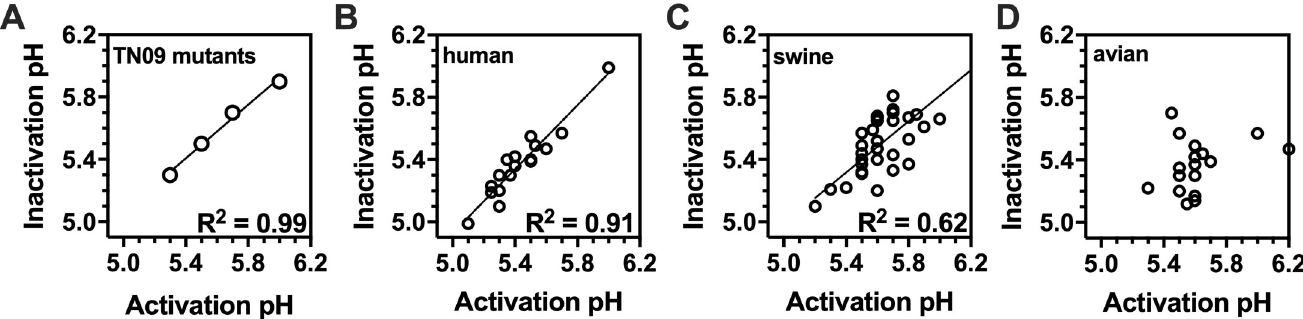
Fig 6. Comparison of HA activation pH and virion inactivation pH values. HA activation pH values were measured by syncytia assay, and virion inactivation pH values were measured by luciferase reporter assay. (A) Comparison for A/TN/09 pH1N1 variants Y17H, Y17H/V55I, WT, and V55I. (B) Comparison for 18 human IAVs. (C) Comparison for 34 swine IAVs. (D) Comparison for 17 avian IAVs. Values shown are average values for at least two independent experiments. The data was analyzed by simple linear regression using GraphPad Prism 8 and calculated R 2 values are reported in the bottom-right corners of panels A-C.